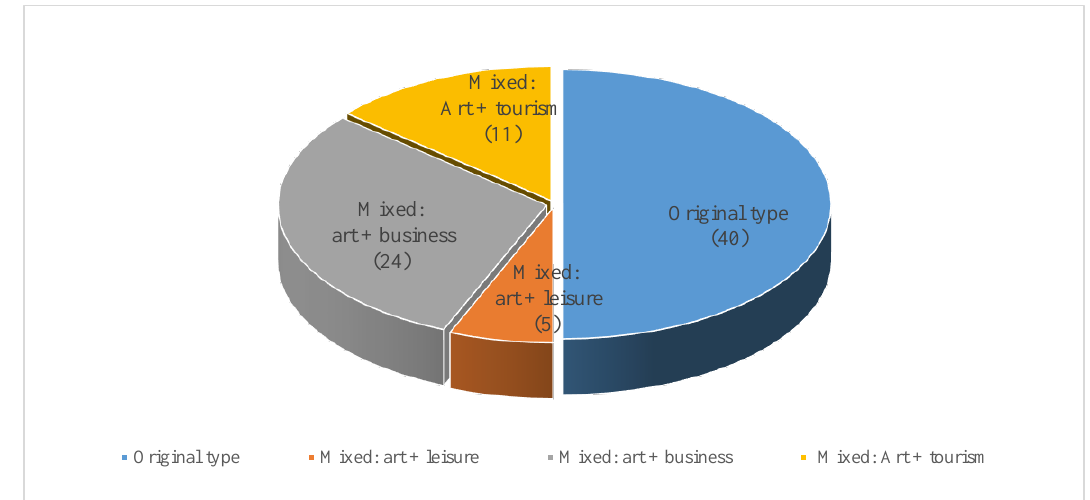
Figure 2. Distribution of Artist Village types.